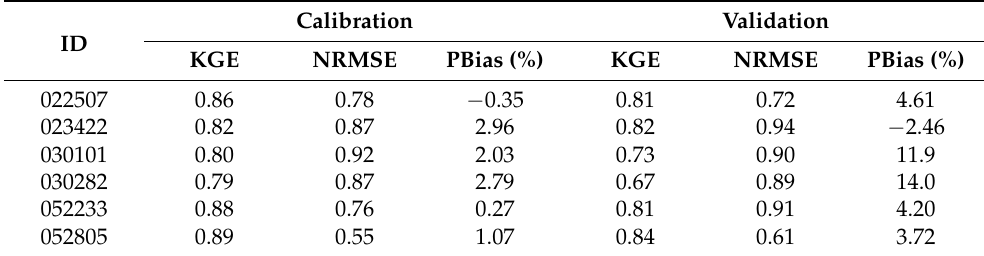
Table 2. Calibration and validation outcomes. KGE: Kling–Gupta efficiency. NRMSE: root–mean– square error normalized by the mean of the flows. PBias: percent bias.